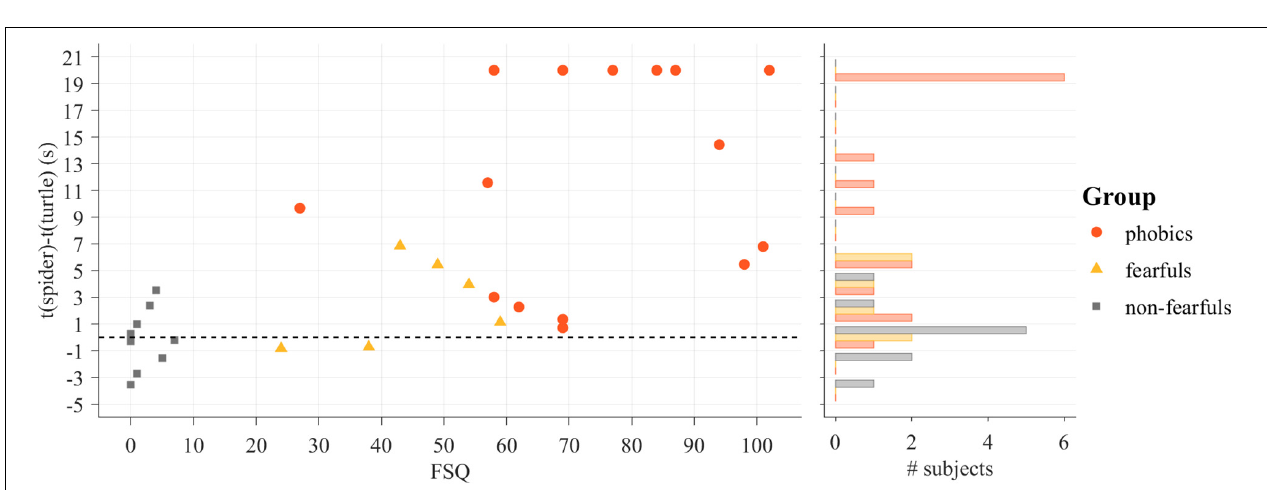
FIGURE 7 | The result of the Touch the Enemy task dependent on the Fear of Spiders Questionnaire (FSQ) score (left) and accumulated in a histogram (right). Individual values were truncated to 20 s.